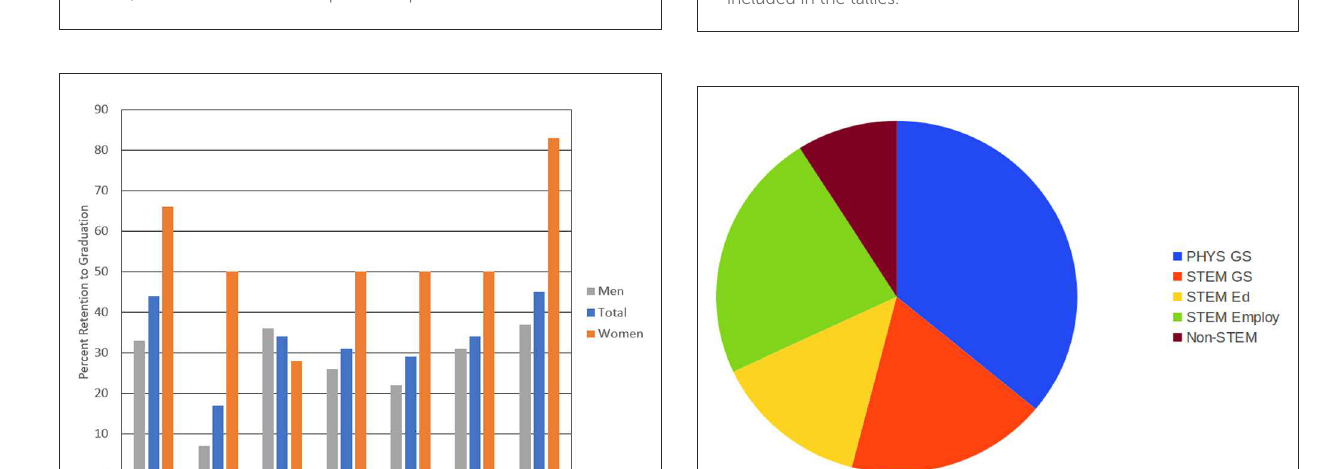
FIGURE3 Percent participation for all Physics Group majors in one (or more) EEL opportunities averaged over 3-year periods. Multiple experiences by the same student were tallied, therefore 100% participation should not be interpreted as every major had a single experience. “On Campus” EEL include inter-disciplinary opportunities with programs like biology, chemistry, computer science, or mathematics. “Off Campus” EEL include internships, REUs, and other collaborative partnerships.